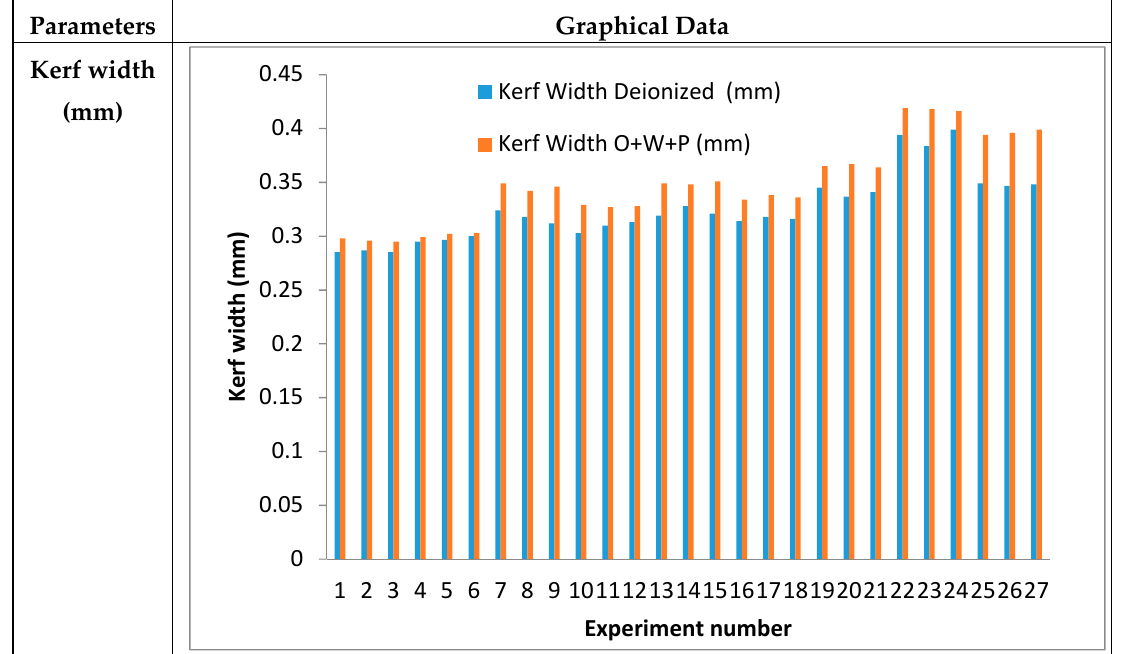
Figure 9. WEDM machined Al-SiC-TiC under close to ideal conditions using deionized water and oil + wax + paraffin as dielectric mediums.